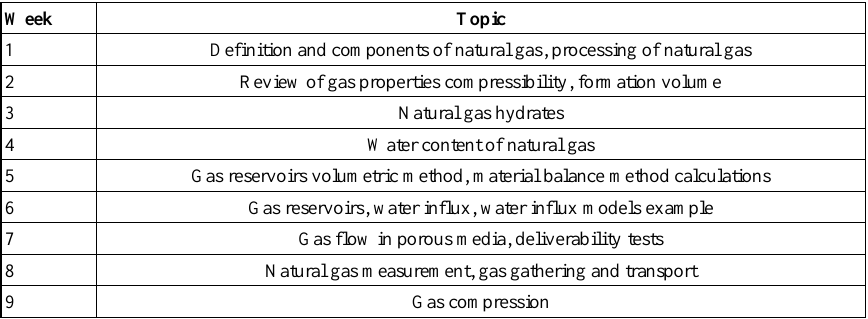
Table 2. Topics taught to the experimental and control group students by weeks